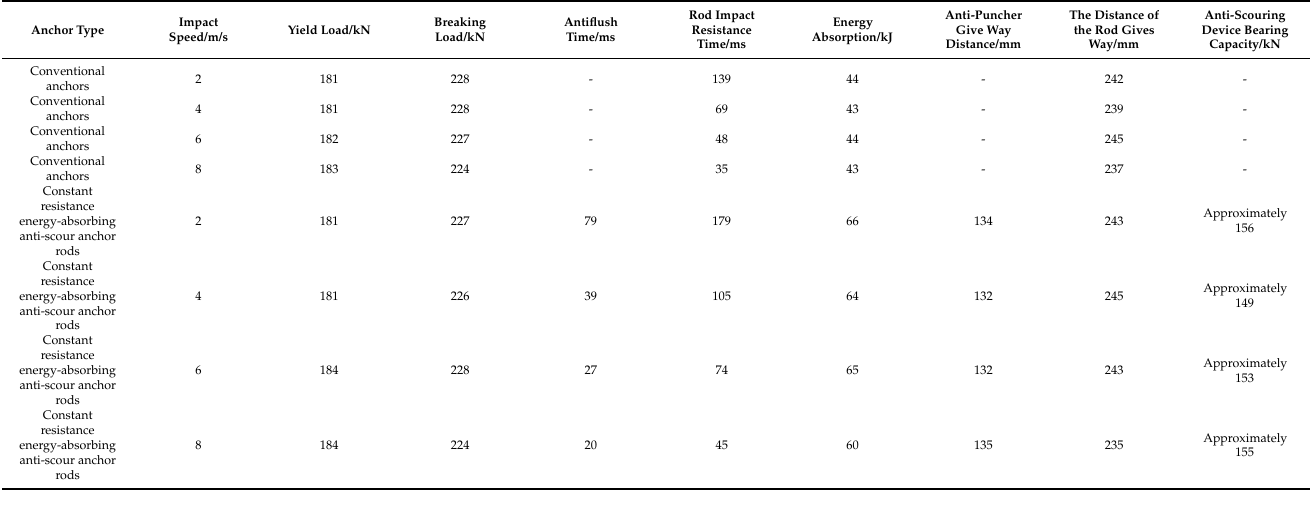
Figure 14. Anchor impact resistance time at different impact velocities. Table 3. Mechanical properties of anchor rods at different impact velocities.